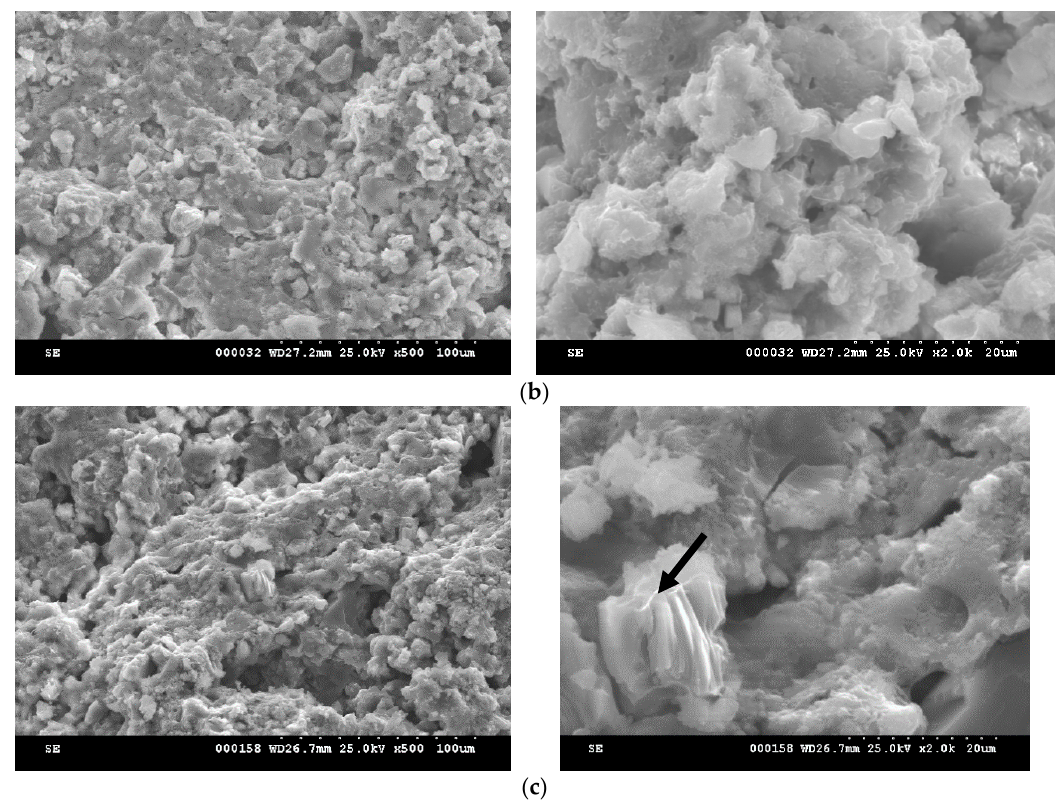
Figure 8. SEM images of MTA1 pastes hydrated for: ( a )—1 day; ( b )—7 days; ( c )—28 days.